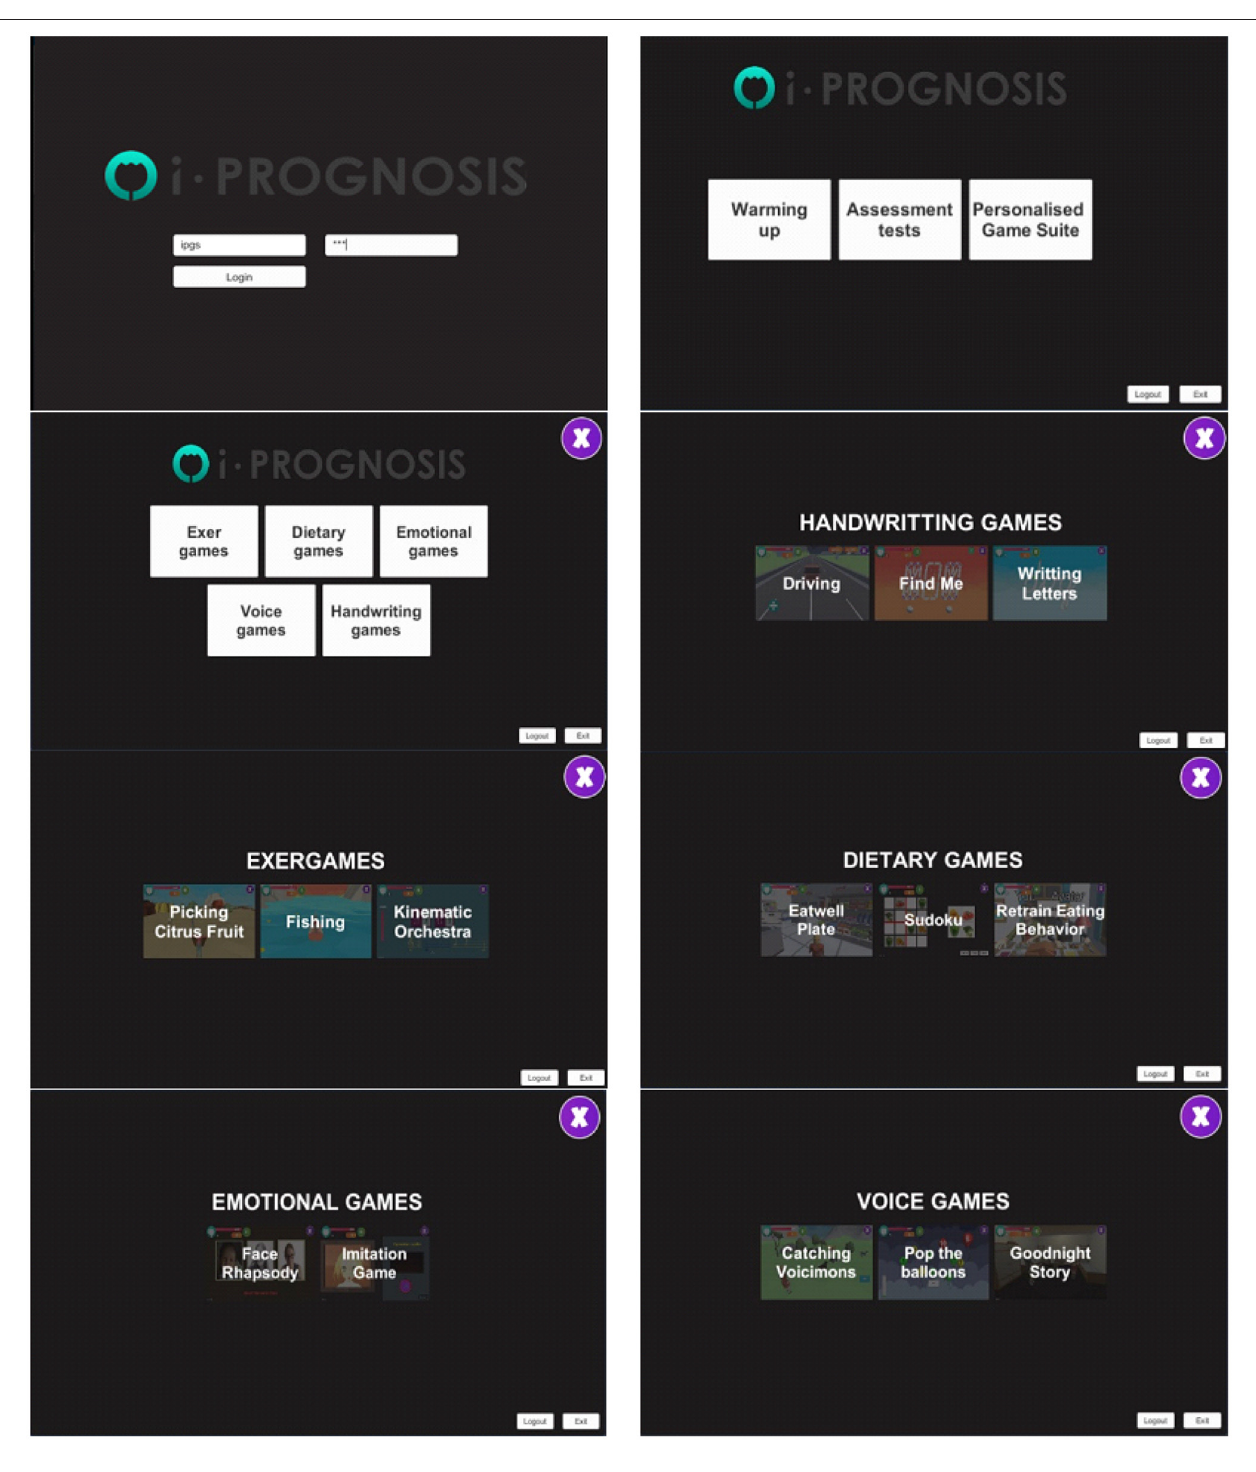
FIGURE 1 | The overview of the i-PROGNOSIS PGS environment. is depicted in Figure 3 . As it can be seen from the latter, the patient with PD (right panel), while being at the premise, tries to imitate the leg movement of the expert (left panel) during